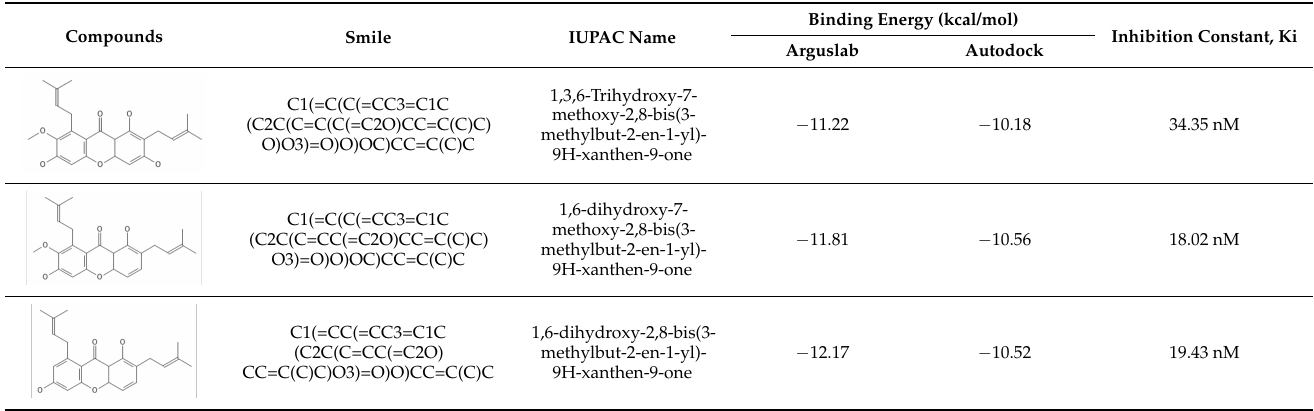
Table 2. The binding energy of compounds binding to beta-tubulin analyzed by ArgusLab and AutoDock